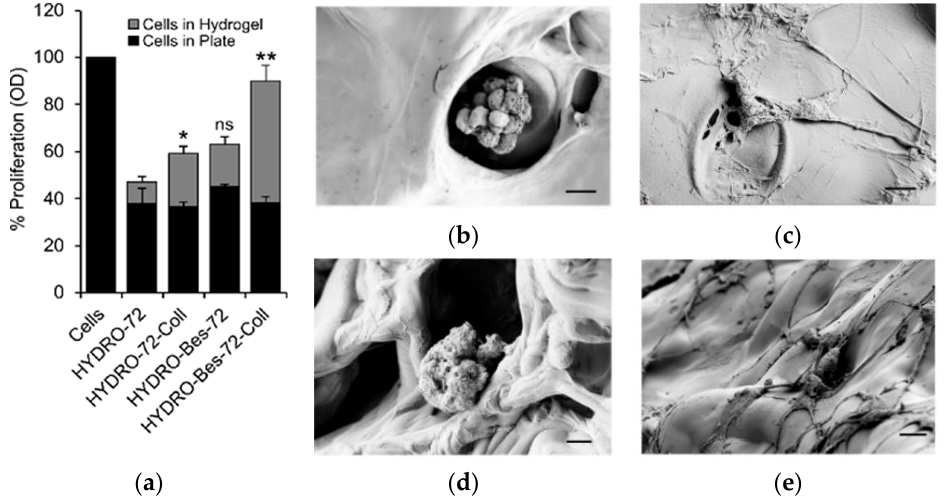
Figure 8. In vitro biological experiments: ( a ) cell viability measured by MTT assay on 10T1/2 fibroblasts cultured in test well bottom (control) and in presence of HYDRO-72, HYDRO-72-Coll, HYDRO-Bes-72, and HYDRO-Bes-72-Coll for 72 h. SEM images of fibroblasts cultured on HYDRO-72 ( b ), HYDRO-72-Coll ( c ), HYDRO-Bes-72 ( d ), HYDRO-Bes-72-Coll ( e ) for 72 h. Significant difference is showed by statistical analysis when * p ≤ 0.05 and ** p ≤ 0.01. ns = not